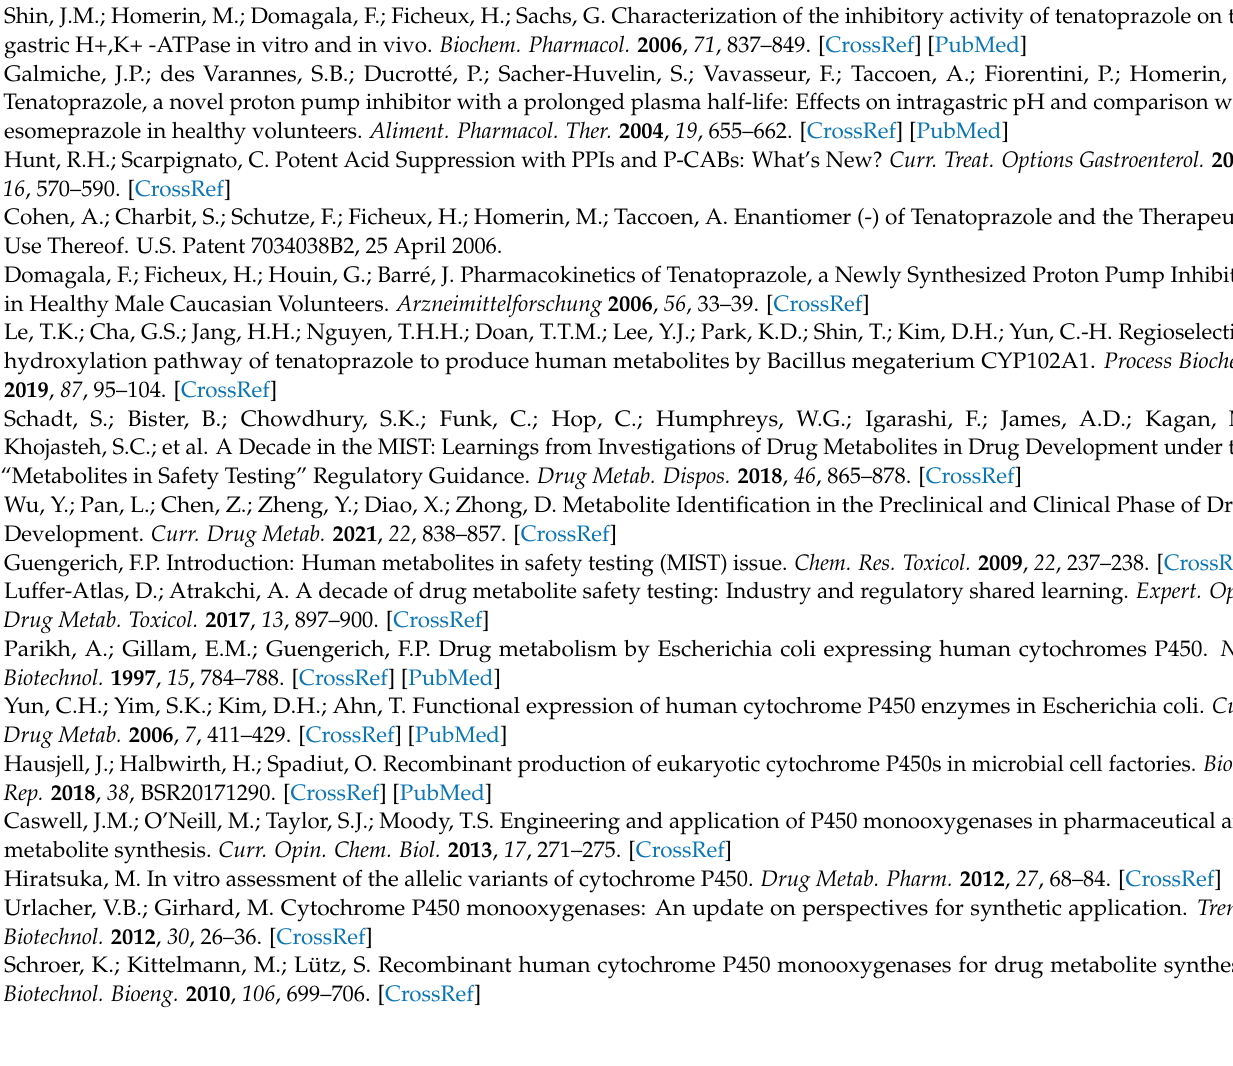
Table S1: Characteristics of tenatoprazole sulfide metabolites of HLMs by LC-QTOF-MS, Table S2: Characteristics of tenatoprazole metabolites of CYP2C19 by LC-QTOF-MS. Table S3: Characteristics of tenatoprazole metabolites of CYP3A4 by LC-QTOF-MS, Table S4: 1 H NMR chemical shifts